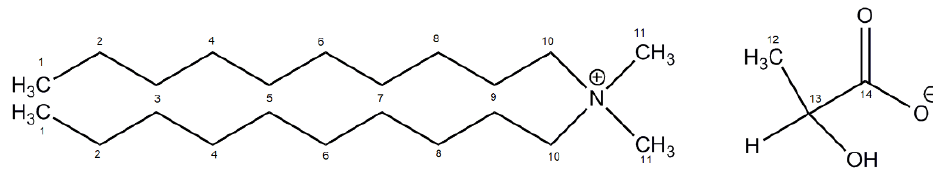
Figure 11. Structural formula of DDALa with marked carbons.